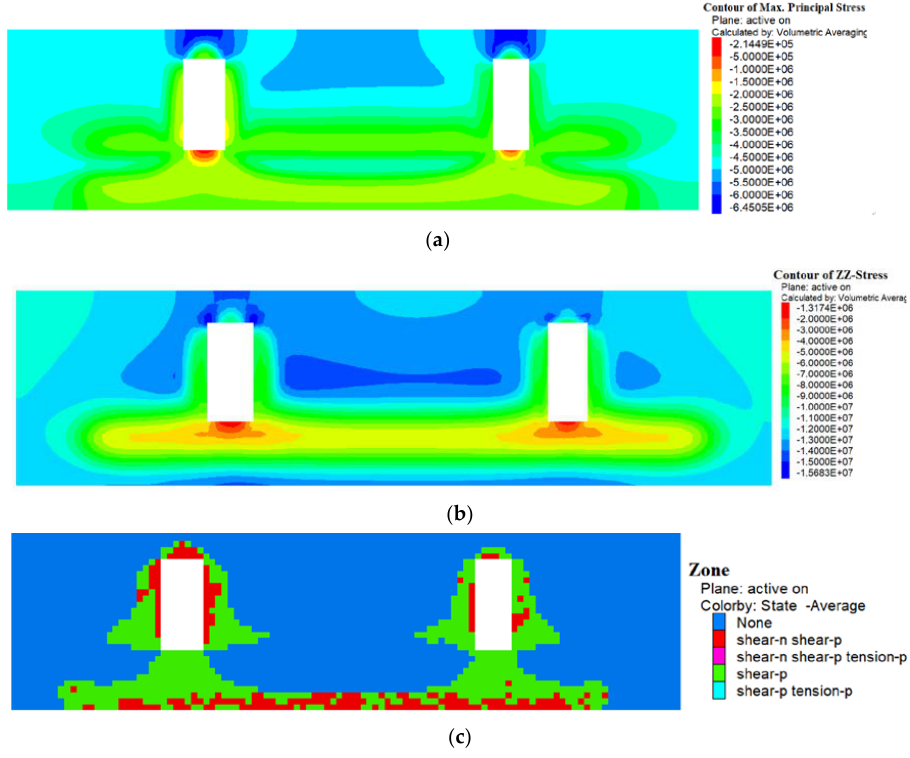
Figure 8. Surrounding rock variation characteristics for h = 8 m. ( a ) Maximum principal stress distribution; ( b ) vertical stress distribution; and ( c ) plastic differential distribution. (1) The simulation result at h = 3 m The height of the roadway near the underground pumping station is 3.5 m, and the surrounding rock variation in the position 3 m away from the coal seam floor is shown in Figure 6. The distribution range of tensile stress generated by the excavation of the cavern is larger than that of the roadway (see Figure 6a). The maximum principal stress is larger in the area between the cavern groups, and the highest value is 8.09 MPa. The distribution law of vertical stress is roughly similar, but the maximum vertical stress value is 22 MPa (see Figure 6b). The larger the section of the cavern, the larger the scope of the plastic zone. The failure mode of the surrounding rock is mainly shear failure (see Figure 6c); (2) The simulation result at h = 5 m The surrounding rock variation in a position 5 m away from the coal seam floor is shown in Figure 7. The peak values of the maximum principal stress and vertical stress decrease to 7.04 MPa and 19.3 MPa, respectively (see Figure 7a,b). The roof position of the roadway is ob- viously in the tensile stress zone, and the stress concentration area of the vertical stress begins to increase. The larger the section of the cavern, the greater the range of stress con- centration. The larger the section of the cavern is, the larger the scope of the plastic zone is. The tensile failure occurs on the two sides of the cavern, the shear failure occurs in the rest of the scope, and the overall scope of the plastic zone increases gradually; (3) The simulation result at h = 8 m The surrounding rock variation in a position 8 m away from the coal seam floor, is shown in Figure 8. The peak values of the maximum principal stress and vertical stress decrease to 6.45 MPa and 15.6 MPa, respectively (see Figure 8a,b). In this section, the stress near the cavern is not affected by the main roadway. The larger the section of the cavern, the greater the stress on the surrounding rock, and obvious stress asymmetry occurs. The plastic zone of the cavern continues to expand to the two sides as it moves away from the floor. The larger the section of the cavern, the larger the scope of the plastic zone. The range and distribu- tion of the plastic zone obtained by numerical simulation are consistent with the theoret- ical results. These results can provide theoretical support for determining the supporting parameters, such as the length of the bolts and the cables;